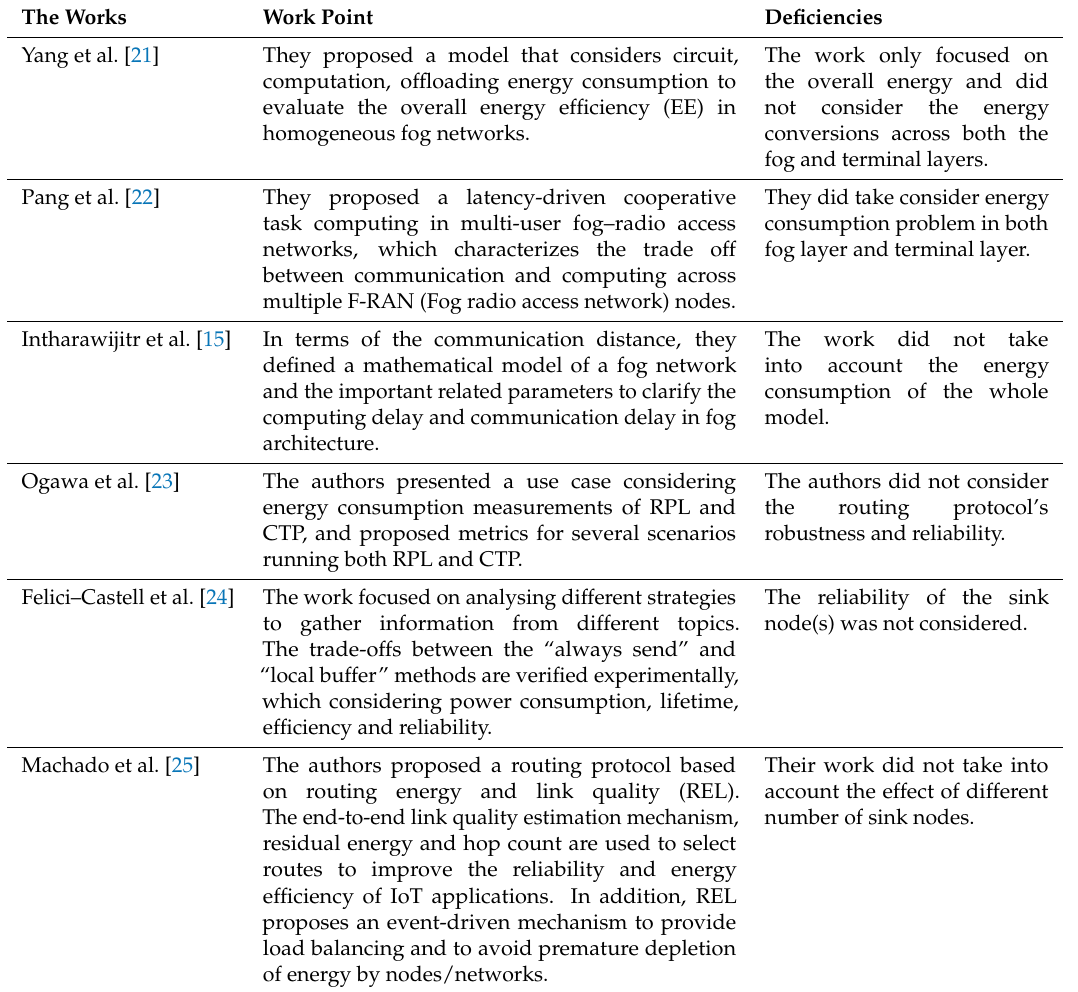
Table 1. Summary of related